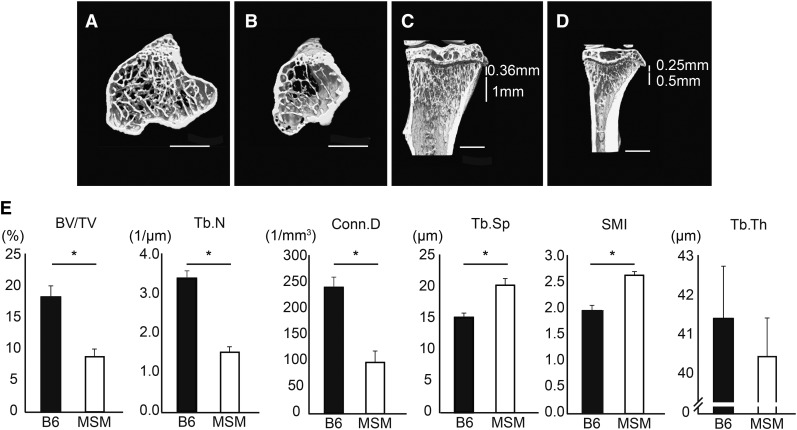
Bone morphology of B6 and MSM at 10 wk of age. (A–D) Representative micro-CT images of the proximal region of tibia of B6 (A and C) and MSM (B and D) mice at 10 wk of age. (A and B) Axial cross-section images; (C and D) sagittal cross-section images. Each ROI is 1 mm in width from 0.36 mm below the growth plate in B6 (C), and 0.5 mm in width from 0.25 mm below the growth plate in MSM (D). Bar, 1 mm. (E) Measurement values of the six parameters, BV/TV, Tb.N, Conn.D, Tb.Sp, SMI, and Tb.Th, of B6 and MSM. Student’s t-test with Welch’s correction was performed for statistical analysis. Significance is declared when *P < 0.01.